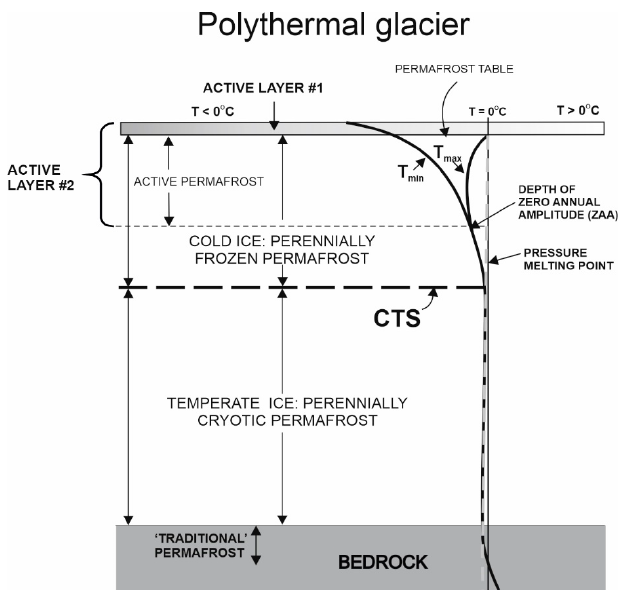
Figure. 1 . Geophysical model of glacial permafrost in polythermal glacier. Active layer #1 is the ice layer melting during the ablation period, reaching a seasonally positive temperature when it rests on the glacier surface in liquid form. Steep glaciers are deprived of it through the outflow. Active layer #2 is an ice layer subject to seasonal temperature variability to the depth of zero annual amplitude (ZAA). CTS—cold-temperate transition surface, Permafrost table—surface of glacier with or without water-layer.